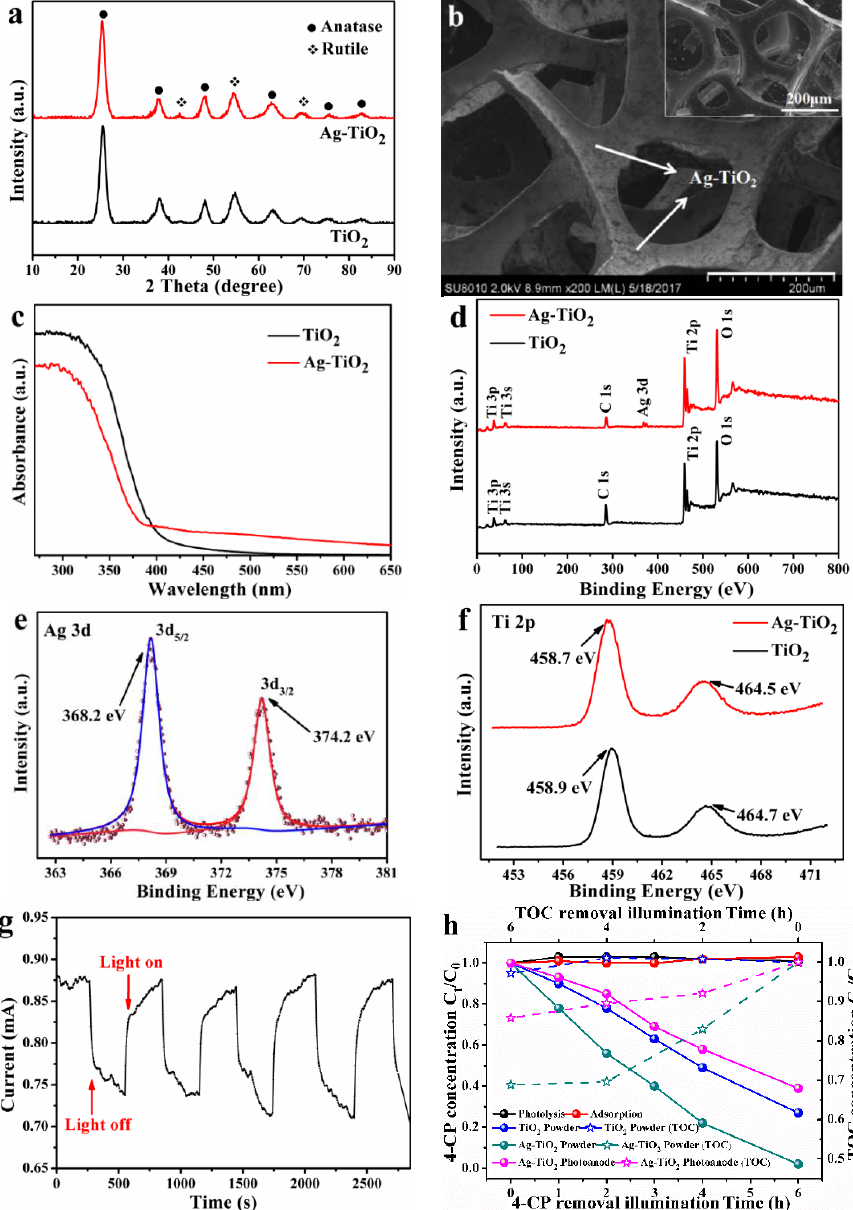
Figure 2. Characterization and photocatalytic performance of as prepared catalyst and electrode. ( a ) XRD patterns of TiO 2 and Ag-TiO 2 nanoparticles; ( b ) SEM images of Ag-TiO 2 nanoparticles coated foamed carbon and pristine foamed carbon (inset); ( c ) DRS spectra of the prepared Ag-TiO 2 and TiO 2 respectively; ( d ) Survey spectra of Ag-TiO 2 and TiO 2 composite nanoparticles; XPS spectra of Ag-TiO 2 nanoparticles for ( e ) Ag 3d and ( f ) Ti 2p; ( g ) Transient photo-current response (on-off mode) and ( h ) photocatalytic degradation and TOC analysis of 4-CP under visible light irradiation.